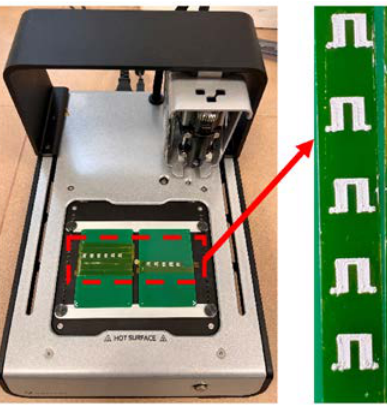
Figure 10. Voltera V-One printer with printed U-shaped traces and printed traces detail.